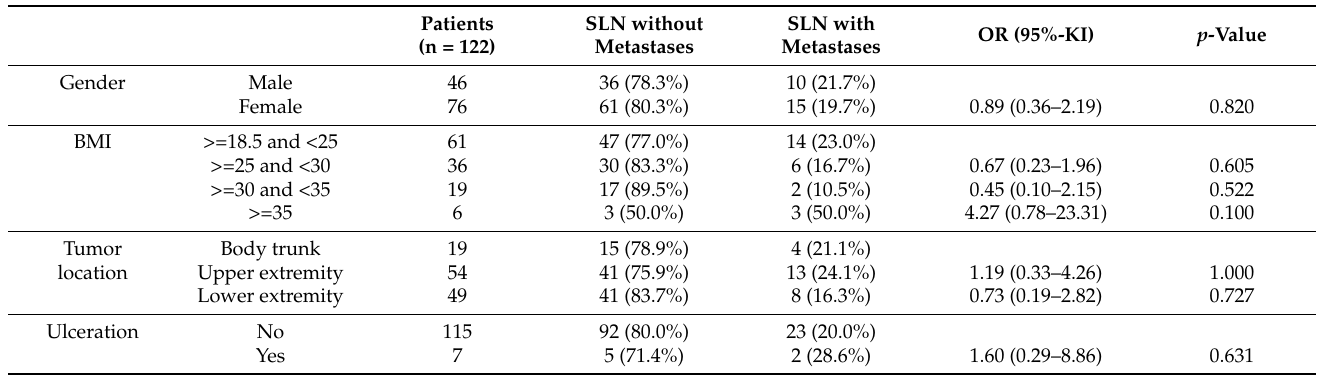
Table 8. Metastases in the sentinel lymph node biopsy in patients with Breslow tumor thickness <1 mm—categorical